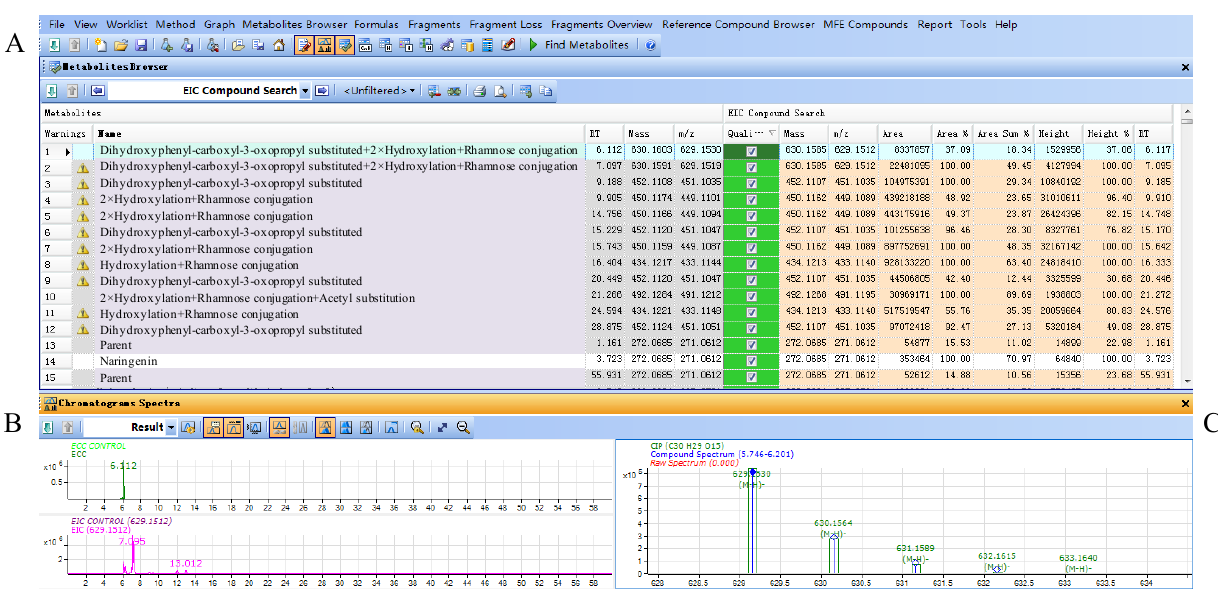
Figure 4. ( A ) Result table for filtered compounds by flavonoid database in Smilax glabra ; ( B ) ECC and EIC chromatograms of selected compound; ( C ) mass spectrum of selected